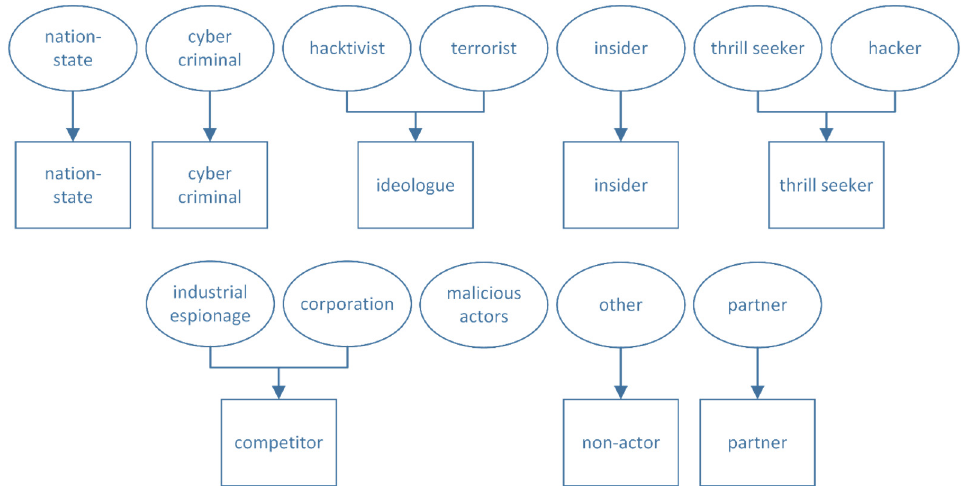
Figure 1. Identified threat actors combined into the eight categories discussed in this paper.